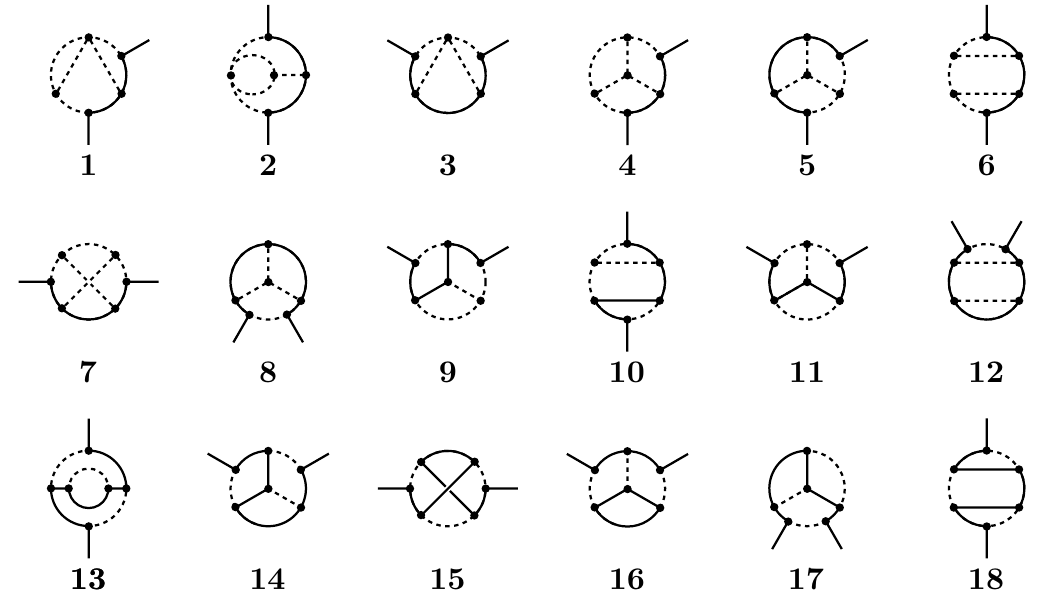
Figure 7 . List of normal genuine diagrams in the mass basis. Note that the two external Higgs lines were removed: in general there is a many-to-one relation between the original diagrams and the amputated ones shown here. Diagrams in this list are referred to in the text as D M the number of the diagram shown here.